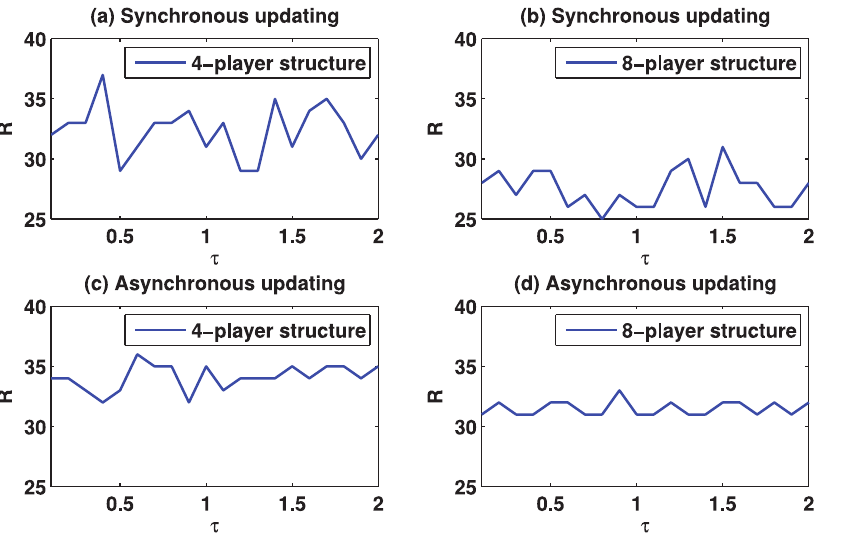
Figure 11. (Color online) Critical value of R ( R t as a function of the parameter ) t on different square lattices. (a) Results on the square lattice with 4-player neighborhood and synchronous updating; (b) Results on the square lattice with 8-player neighborhood and synchronous updating; (c) Results on the square lattice with 4-player neighborhood and asynchronous updating; (d) Results on the square lattice with 8-player neighborhood and asynchronous updating.